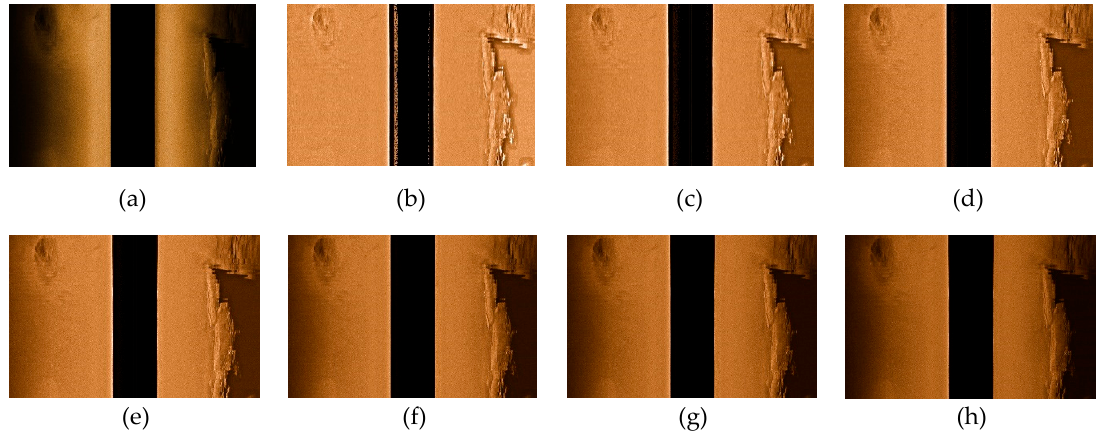
Figure 6. Experimental comparison using mean filter. (a) Original image and corrected image with and (b) ɑ = 0, (c) ɑ = 5, (d) ɑ = 10, (e) ɑ = 15, (f) ɑ = 30, (g) ɑ = 40, and (h) ɑ = 60.